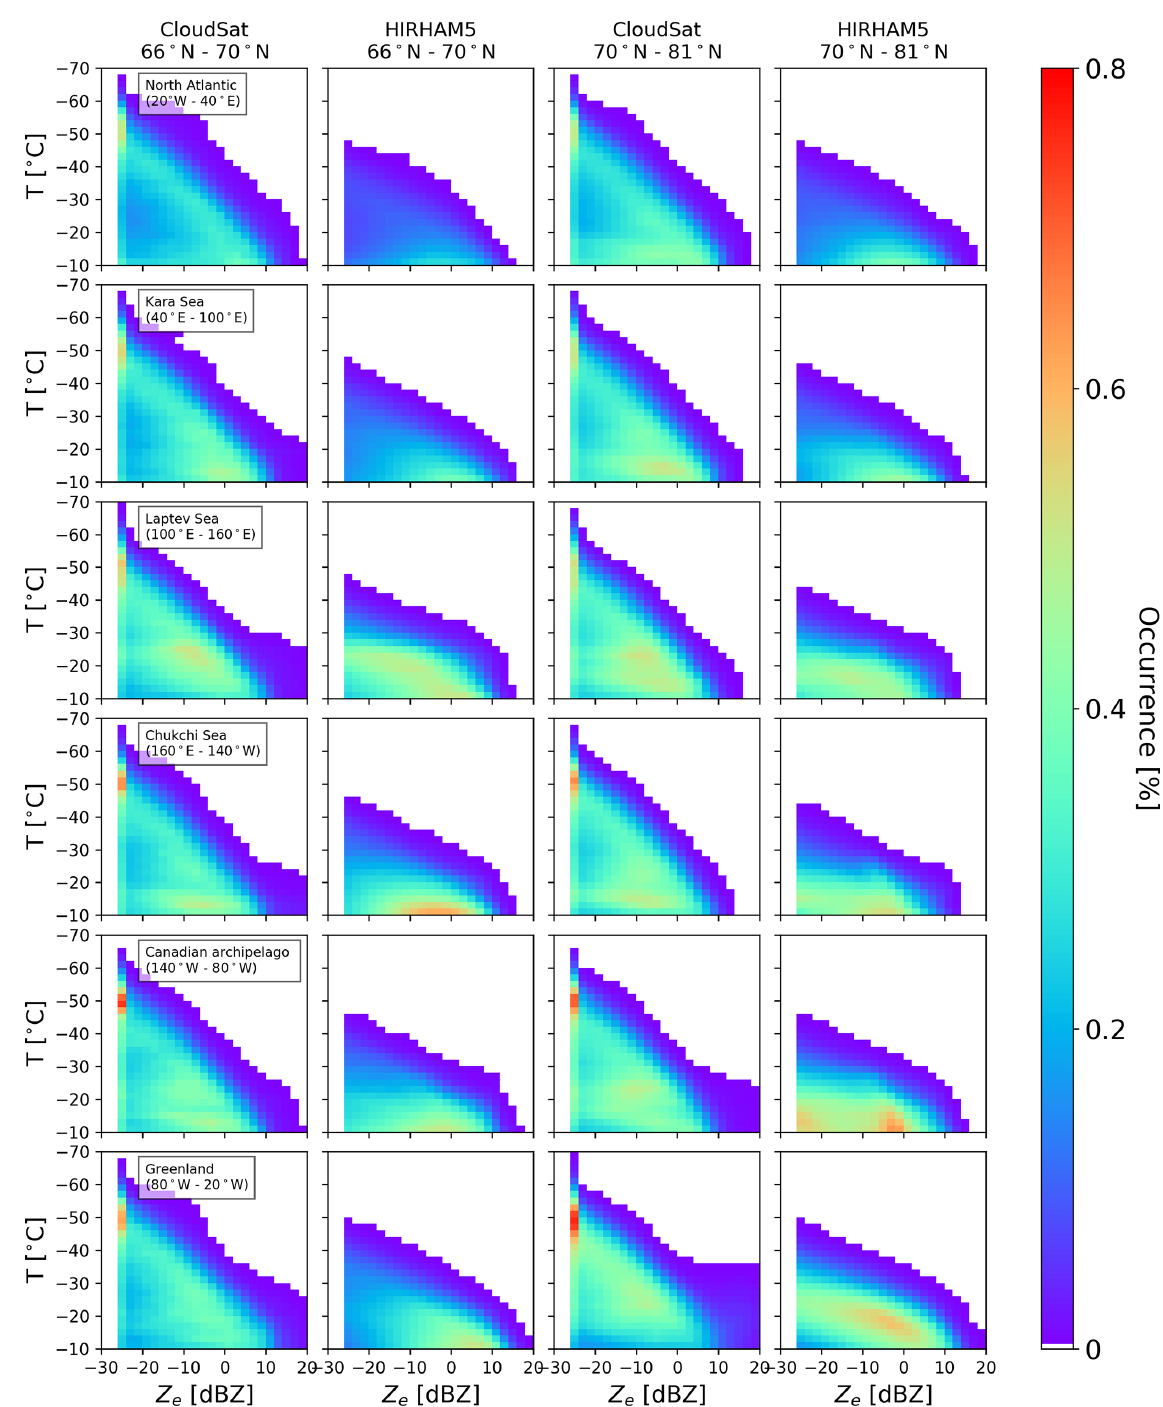
Figure A9. The observed and modeled CFTDs for both latitude band regions in the autumn season (SON, 2007–2010). On the x axis is the reflectivity in dBZ, and on the y axis is the temperature from − 70 to − 10 ◦ C. The normalization is done by the sum of total